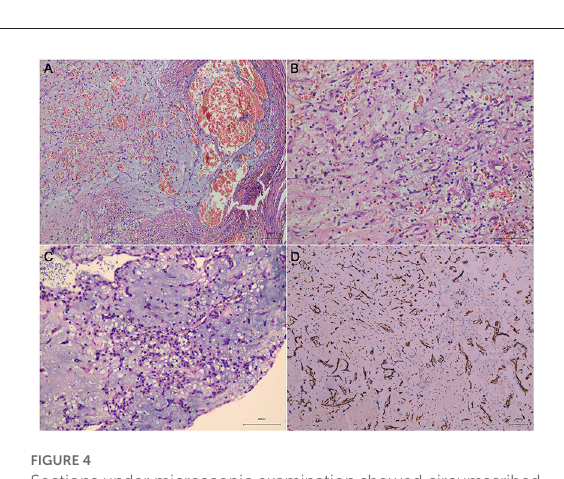
FIGURE4 Sections under microscopic examination showed circumscribed fragments of fibrocol-lagenous tissue and some ectatic vascular channels with hemorrhage ( A, B , metastatic cerebral sites). Under light microscopy, myxomatous component is seen. It is characteristically composed of stellate or fusiform shaped cells surrounded by loose stroma with abundant basophil cells in-filtration ( C , cardiac myxoma). Immunohistochemical stain revealed positive expression of CD34 (D) .